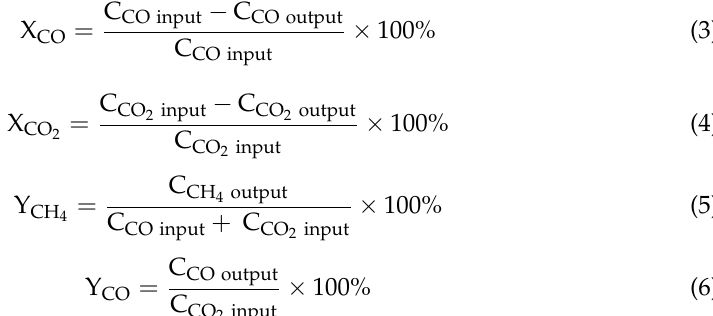
Figure S10. In situ DRIFTS spectra after adsorption of CO 2 on the Co/CeO 2 (500) catalyst at 300 ◦ C. The feed was composed of 10 mol% CO 2 and 90 mol% He. Table S1: Quantitative analysis of the CO 2 -TPD